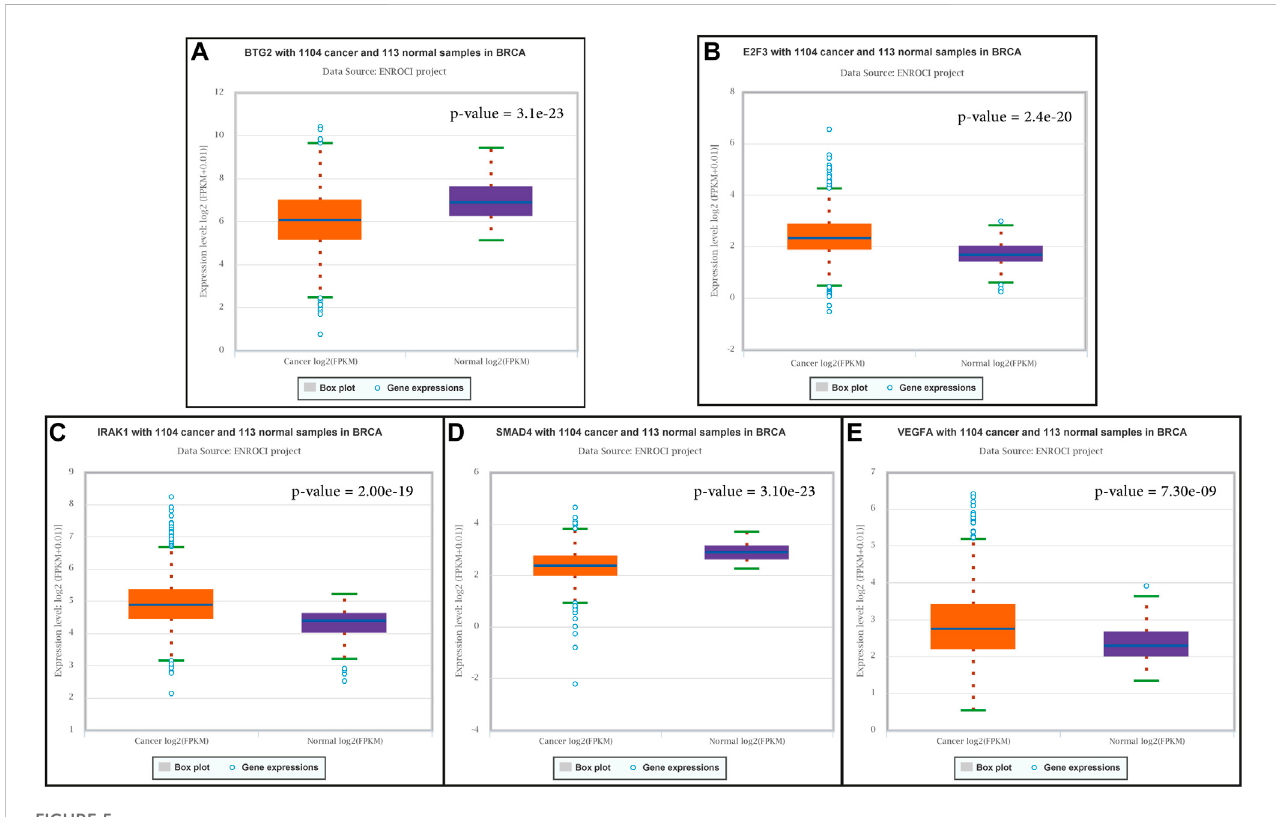
FIGURE 5 Expression of target genes of studied miRNAs in pan-cancer data.